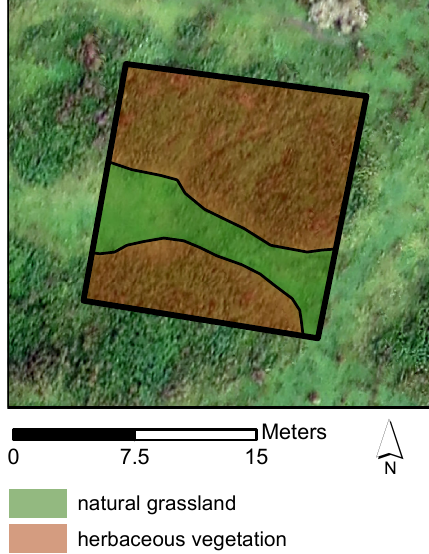
Figure 2. Example of a field plot with mixture of grassland and herbaceous vegetation, which was divided into homogeneous polygons with field sketches of